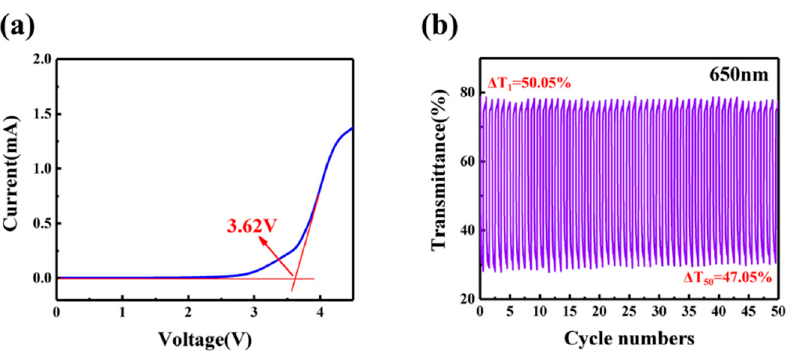
Figure 6. ( a ) Linear sweep voltammetry curve for GPE-ILs. ( b ) Transmittance of ECD with GPE-ILs at 650 nm for 50 cycles.